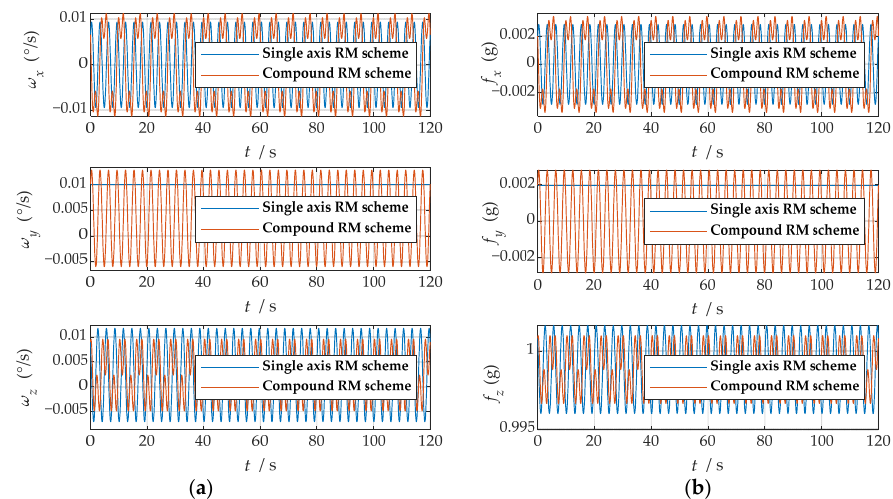
Figure 7. The navigation information of the b-frame obtained after coordinate system transformation: ( a ) angular velocity information; ( b ) specific force information.